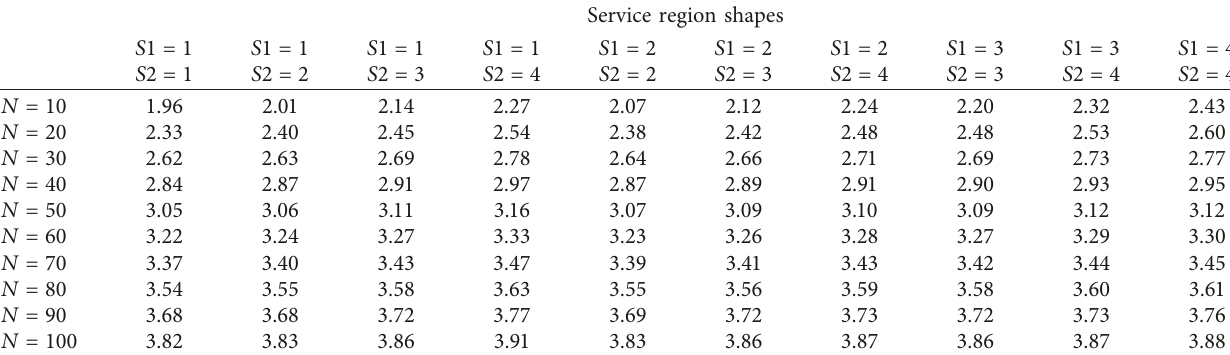
Table 6: Ratio of L